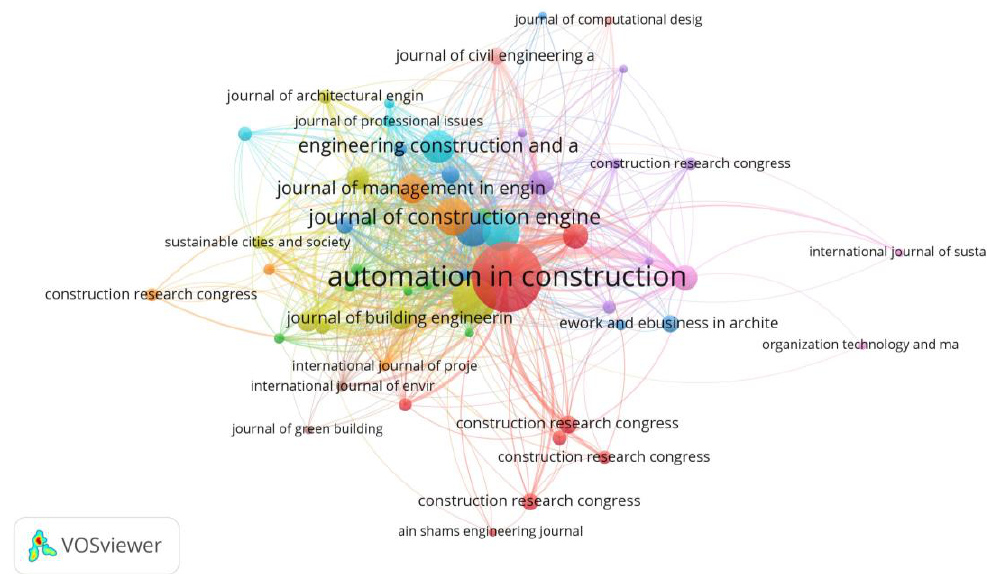
Figure 10. Network of journal co-citation.